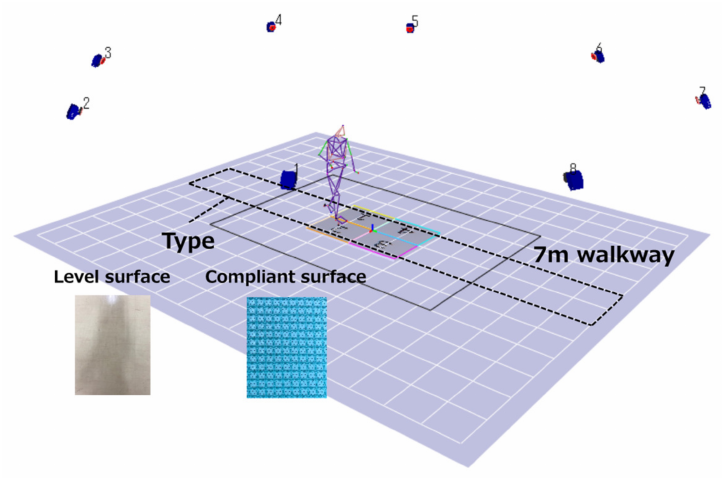
Figure 1. Participants walked on the level surface and compliant surface.